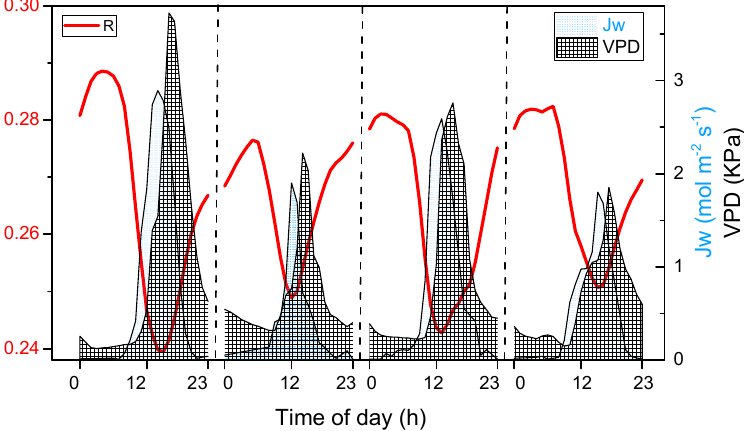
0.28 Figure 9. Oscillation of diurnal bioristor signal R (continuous line), water flux density Jw (blue filled area) and VPD (grid filled area) recorded over 4 consecutive days separated by vertical dashed lines. 0.240.26